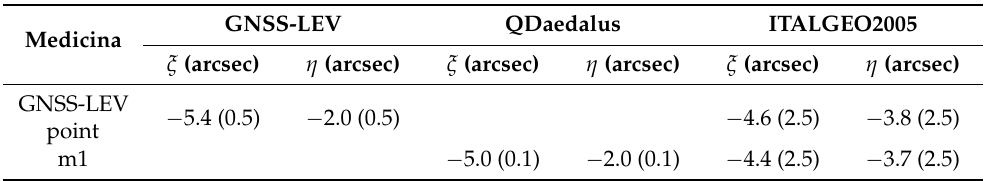
Table 1. Components of the DoV obtained by the three methods for the Medicina site; standard deviations are given in brackets.